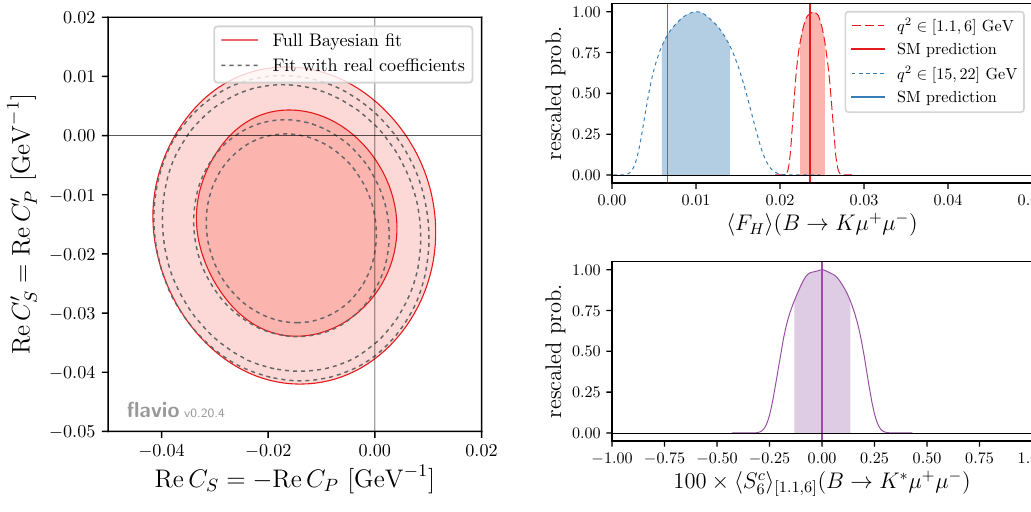
Figure 4 . Left: marginal posterior distribution from a Bayesian (cid:12)t with (cid:13)at priors for the real and imaginary parts of the Wilson coe(cid:14)cients C S and C 0 showing the 1 and 2 (cid:27) (68 : 3% and 95 : 5% posterior probability) contours. For comparison, the case of real Wilson coe(cid:14)cients from (cid:12)gure 3 is shown as dashed contours. Right: posterior prediction from the Bayesian (cid:12)t for the (cid:13)at term F H in B same maximum probability), and the angular observable S c to their SM predictions.